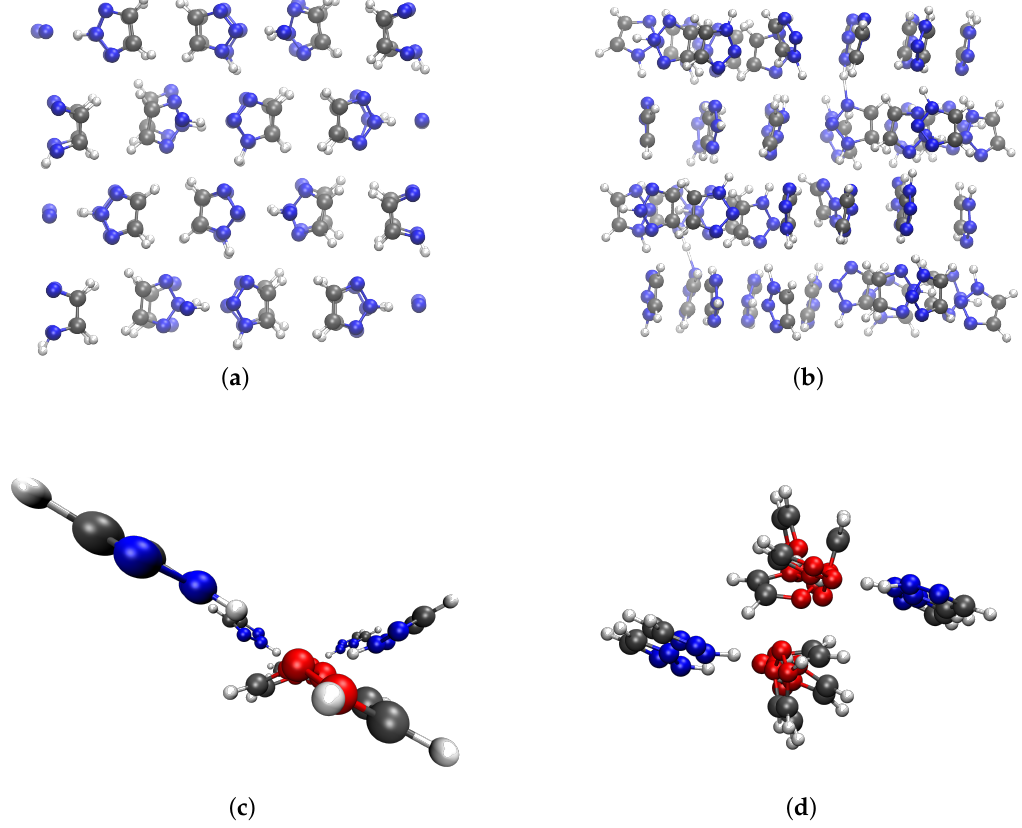
Figure 3. Graph ( a ) shows a snapshot taken from the simulation of the orthorhombic phase at 280K. Below (graph ( c )), the side view of a cutout of the crystal structure is shown. The graphs of the right side ( b , d ) show the same perspective but for the monoclinic phase at 269K. In the lowermost graphs, nitrogen atoms of the 2H-triazole are shown in blue whereas the nitrogen atoms of the 1H-triazole are shown in red to distinguish between the two